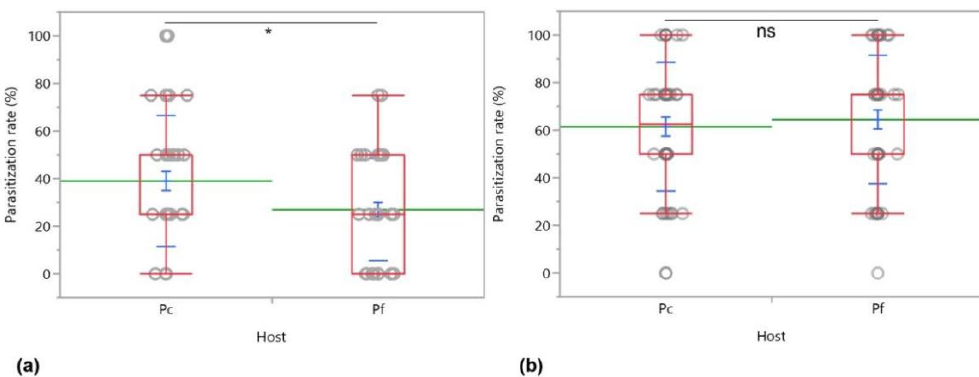
Figure 9. Parasitization rates of Anagyrus vladimiri on Pseudococcus comstocki (Pc) and Planococcus ficus (Pf) during a two-choice direct observation lasting 20 min ( a ), and after a 24 h-exposure period of the mixed mealybug population (4 + 4 young females) to the parasitoid ( b ). Each box plot indicates the median (central line) and its range of dispersion (lower and upper quartiles, and outliers); green lines indicate the means, while light blue T-bars indicate standard errors. The asterisk indicates a significant difference (Wilcoxon test, p < 0.05); ns = not significant.